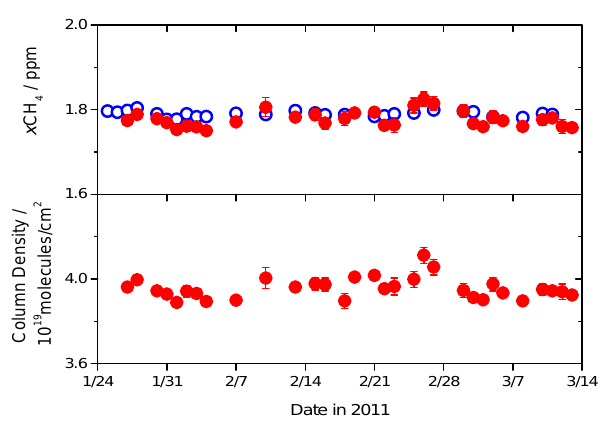
Fig. 8. Time series of column density and x CH 4 with the stan- dard deviations at JAXA in Tsukuba, Japan. OSA: solid circles (SF=1.035); FTS: open circles